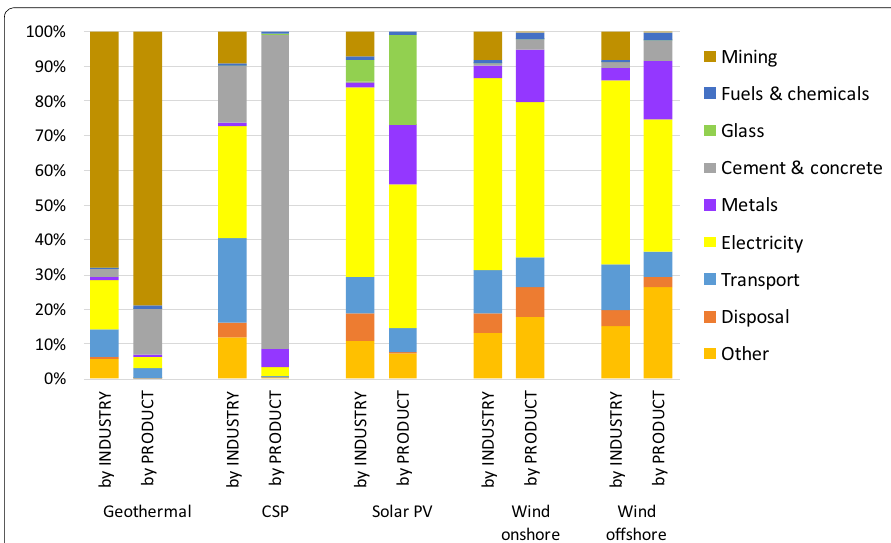
Fig. 5 Decomposition of greenhouse gas life cycle (carbon footprint) inventories of renewable electricity generation technologies by industry ( left column , cf. Wolfram et al. 2016) and by product ( right column , this work). CSP concentrated solar power, PV